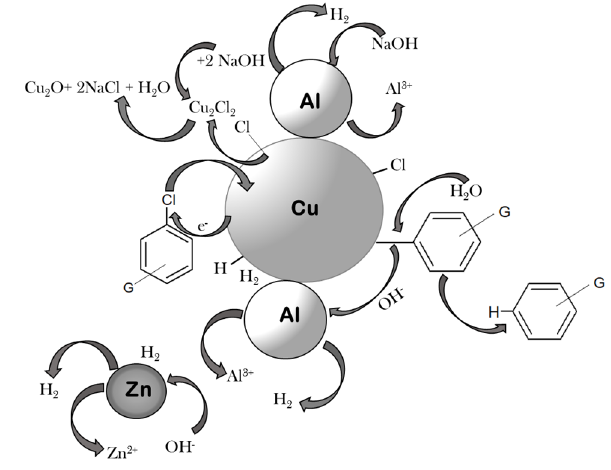
Figure 12. Scheme of HDC mechanism using the Devarda’s Al-Cu-Zn alloy (G=Cl 5 ; m -NH 2 or o -NH 2 ).